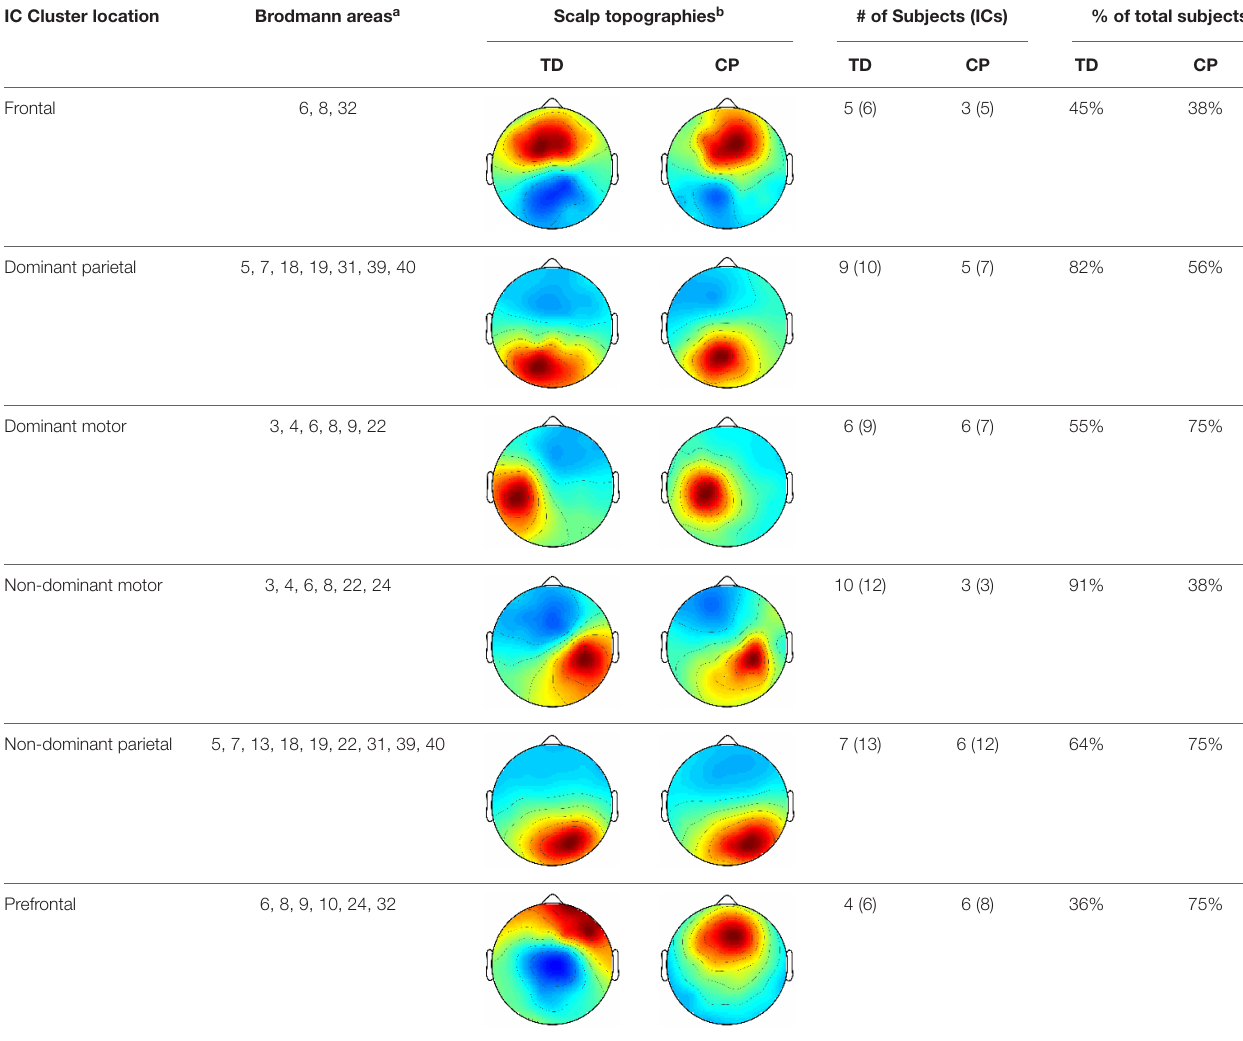
TABLE 3 | IC Cluster characteristics.